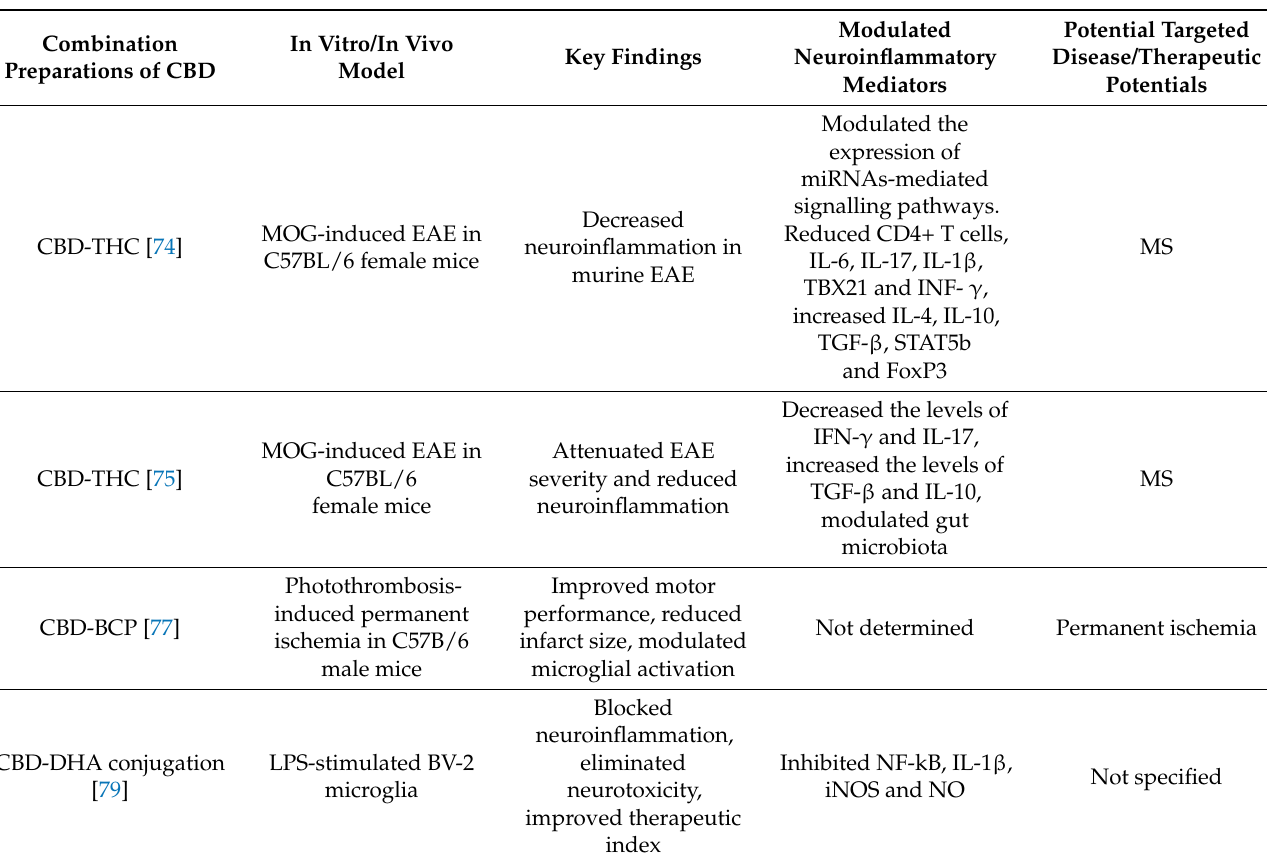
Table 3. Anti-neuroinflammatory effects of CBD/CBD conjugates with other bioactive compounds in Cannabis and pharmaceutical